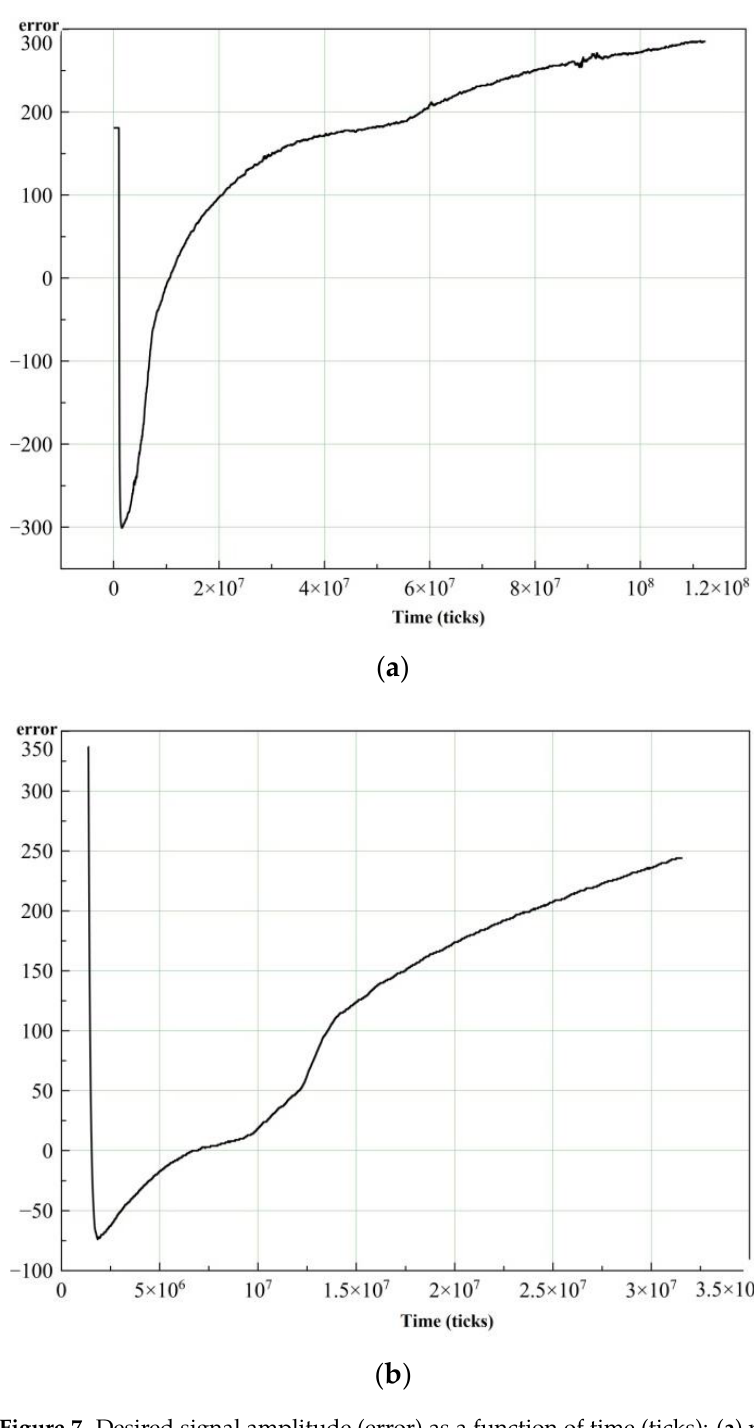
Figure 7. Desired signal amplitude (error) as a function of time (ticks): ( a ) power consumption of 80%, ( b ) power consumption of 90%.